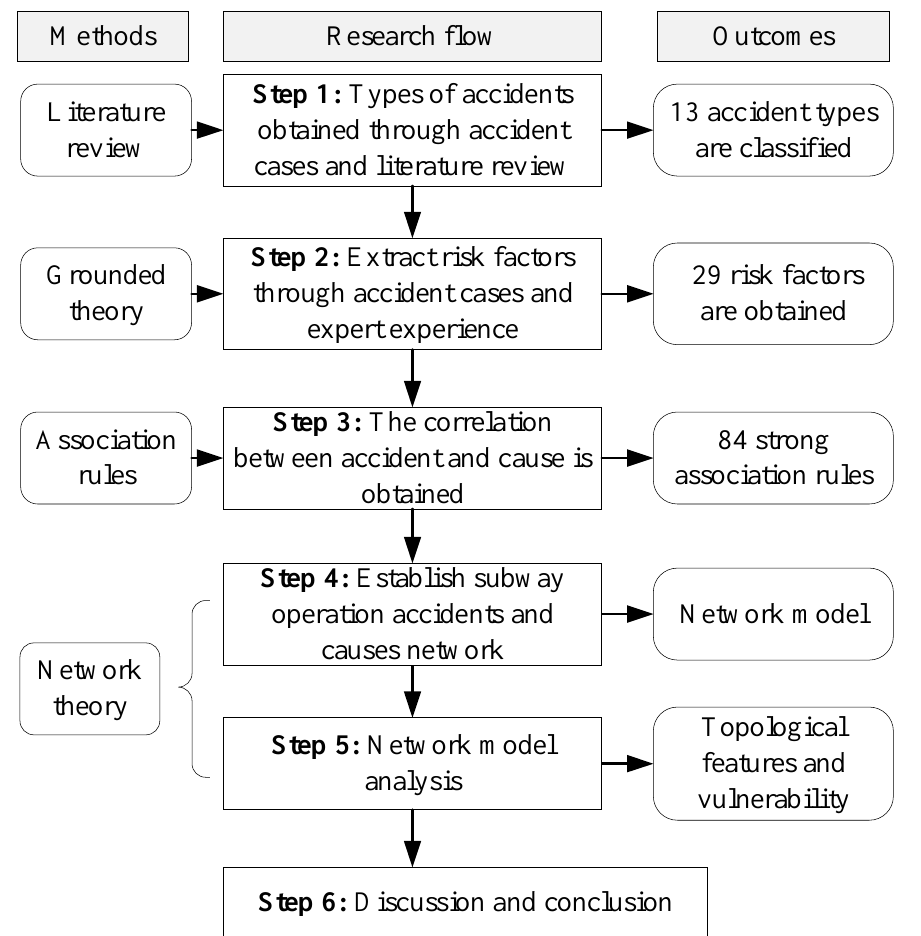
Figure 2. The analytical